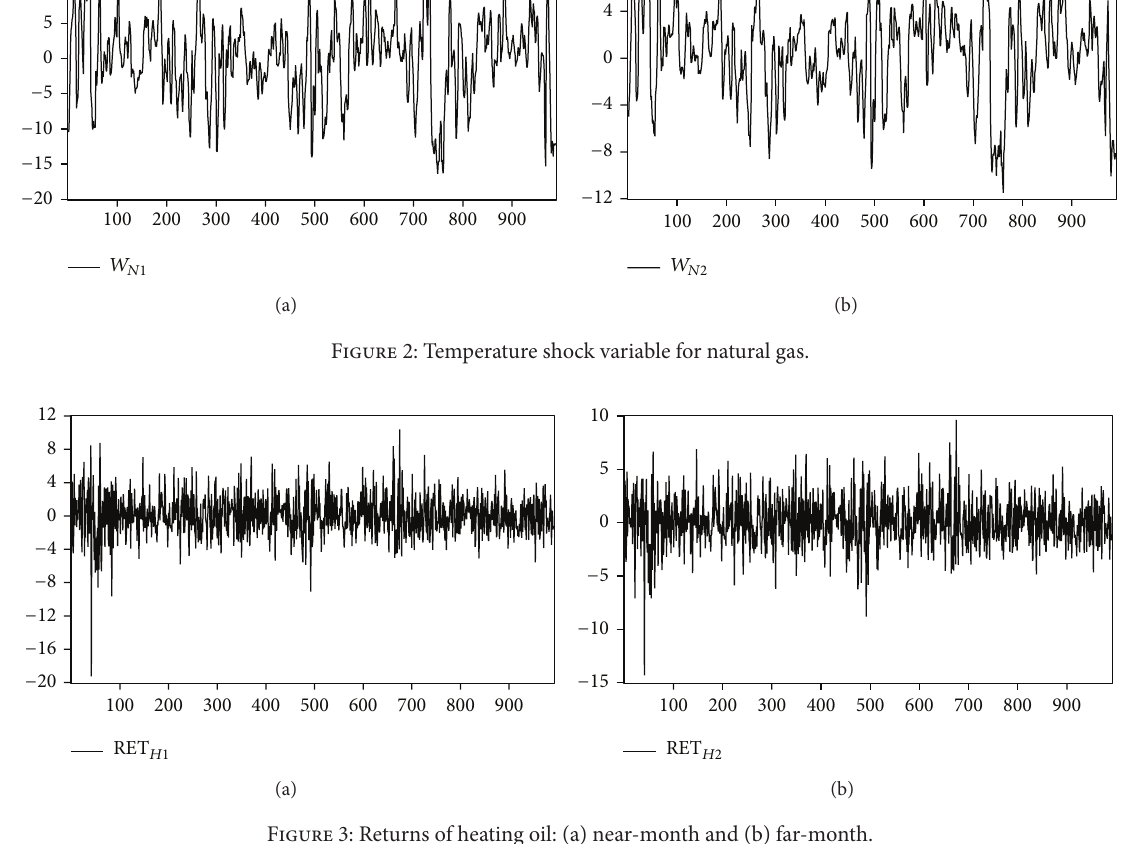
Figure 3: Returns of heating oil: (a) near-month and (b) far-month.